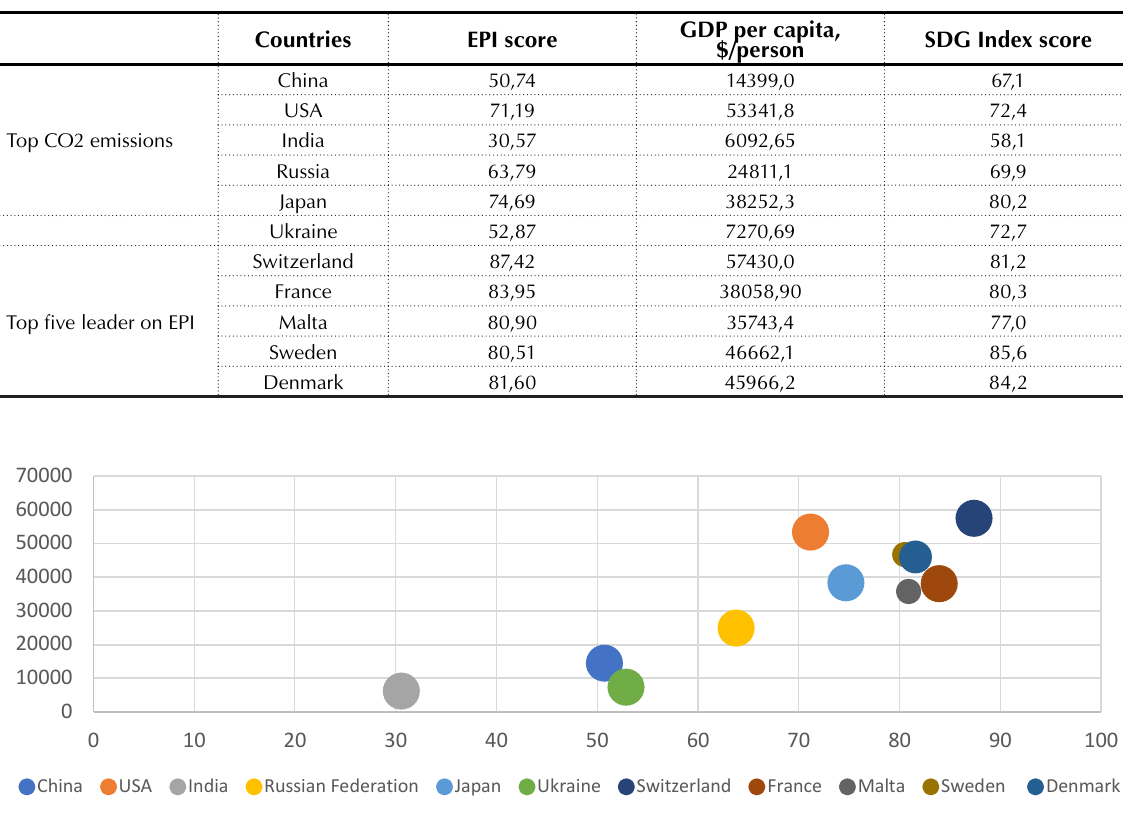
Table 6. Comparison analysis of EPI, SDG index and GDP per capita Source: Created by the authors on the basis of Environmental (2018), SDG (2018).